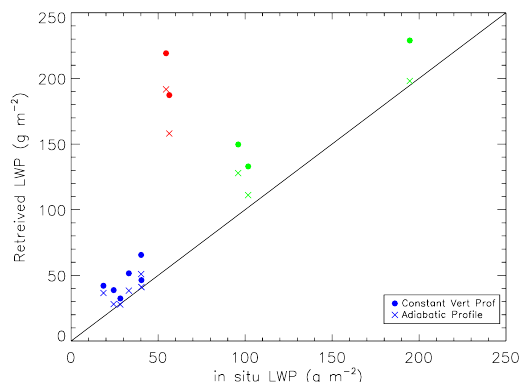
Fig. 5. Comparison of LWP retrieved by MODIS and measured in situ. Dots represent LWP retrievals using the standard assumption of a vertically constant profile crosses represent estimates of LWP using an adiabatic assumption. Red points are clouds whose 2DS LWPs were > 10gm − 2 , green points have a 2DS LWP in the range 1–10gm − 2 and blue points have a 2DS LWP < 1gm −